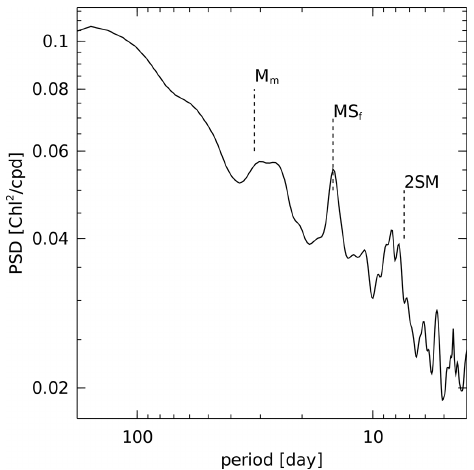
Figure 2. Spectral estimate of Chl a concentration off the north- west coast of Australia (21 ◦ S, 114 ◦ E). The spectral estimate is computed by averaging Lomb–Scargle periodograms based on Hamming-windowed data within 120d segments. A narrow peak is evident at the MS f frequency (corresponding to 14.77d, the M 2 – S 2 spring–neap cycle), and broadband variance is present close to the first sub- and super-harmonics of MS f (denoted M m and 2SM). Harmonic analysis at the M m and 2SM frequencies, and at nearby compound overtide frequencies, did not find significant